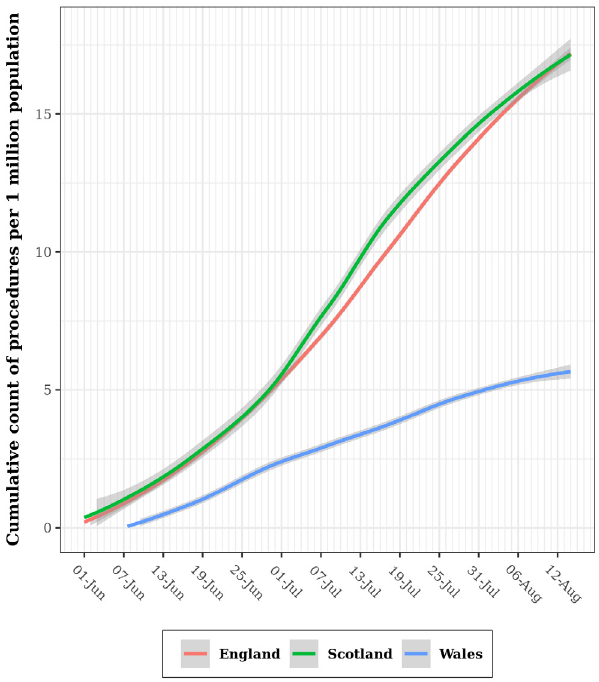
Figure 1. Number of operative procedures performed in each region. Figure 2. Changes in capacity over time. The nations effect.